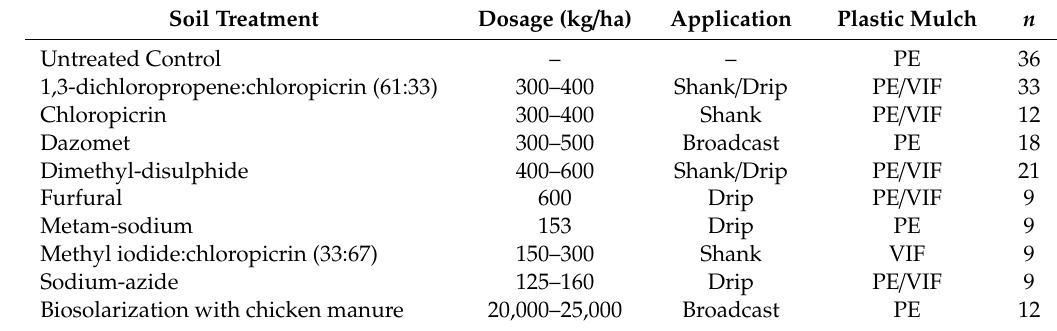
Table 1. Soil disinfestation treatments applied to a field naturally infested with Meloidogyne hapla to determine their e ffi cacies in reducing soil nematode densities.